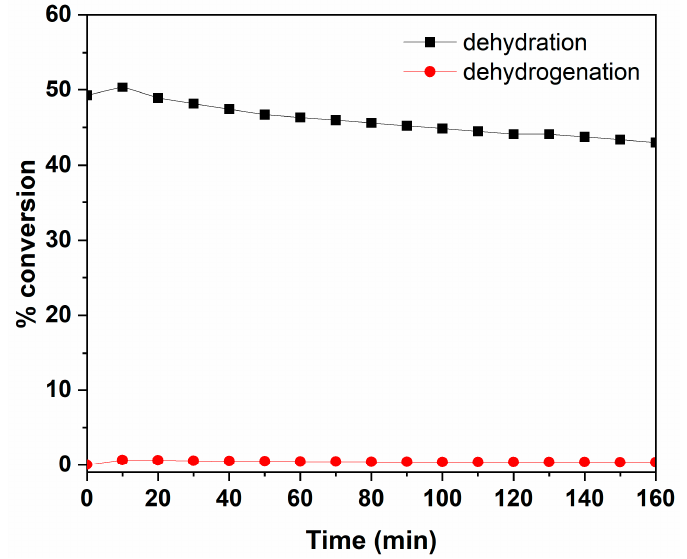
Figure 5. Dehydrating and dehydrogenating curves of 2-butanol over ZrP 2 O 7 under N 2 at 185 °C (in absence of oxygen) as a function of time.